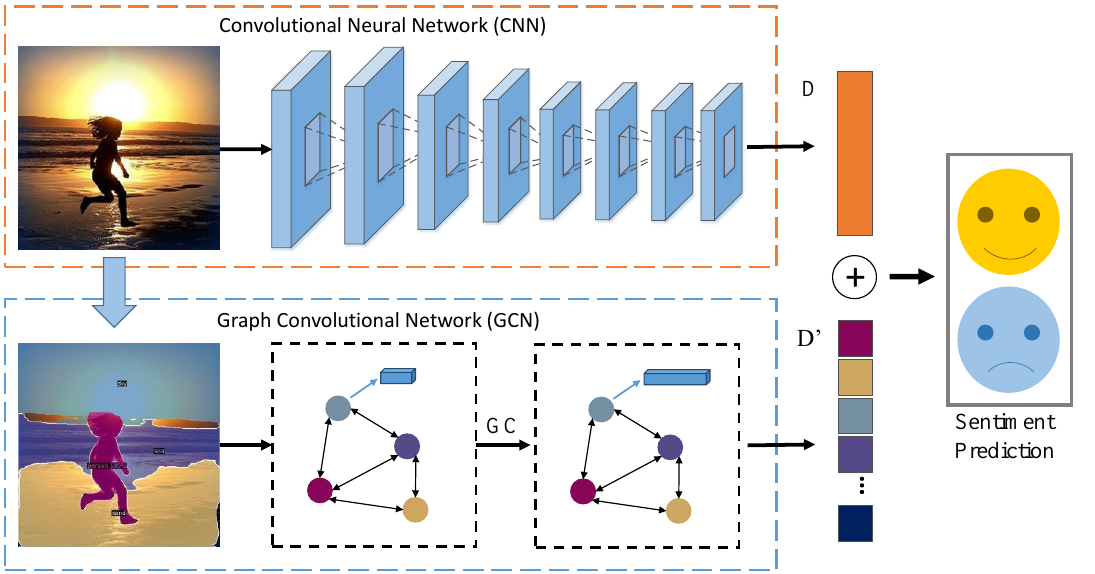
Figure 2. Pipline of proposed approach